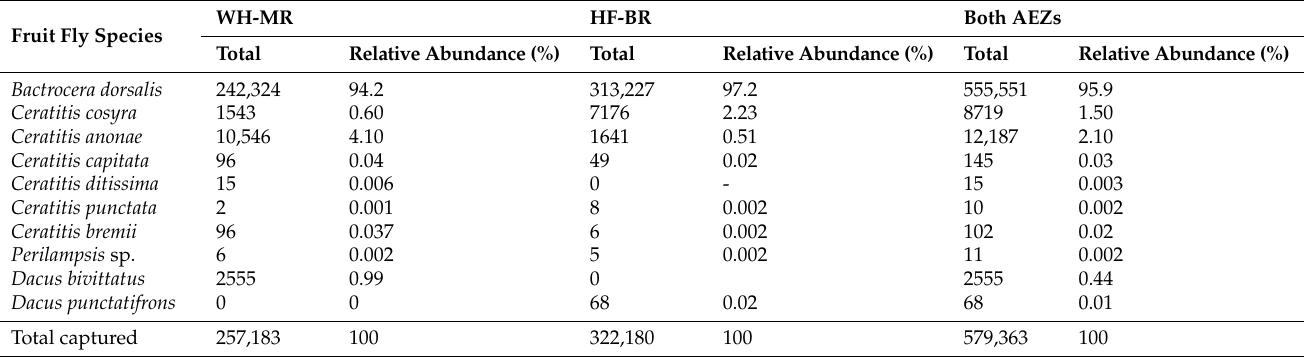
Table 3. Abundance of fruit fly species caught in traps in two agro-ecological zones of Cameroon using three attractants during the trapping period